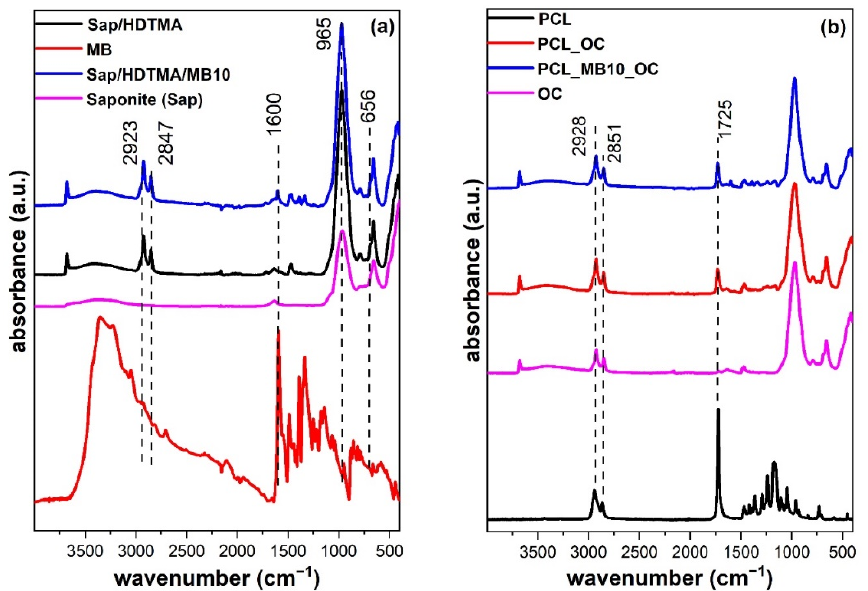
Figure 3. ATR spectra of saponite (Sap), methylene blue (MB), organoclay (OC, MB10) ( a ), polycaprolactone (PCL) and its composites (PCL/OC, PCL/MB10) ( b ). The chemometric method multivariate curve resolution—alternating least squares (MCR) was used to decompose the matrix of measured spectra for semi-quantitative esti-